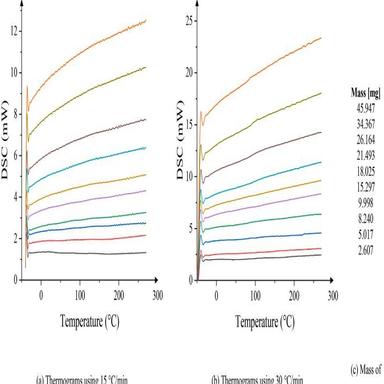
DSC results considering different amounts of Kryonaut: heating rate of (a) 15 ◦C/min and (b) 30 ◦C/min, and the corresponding mass table (c).